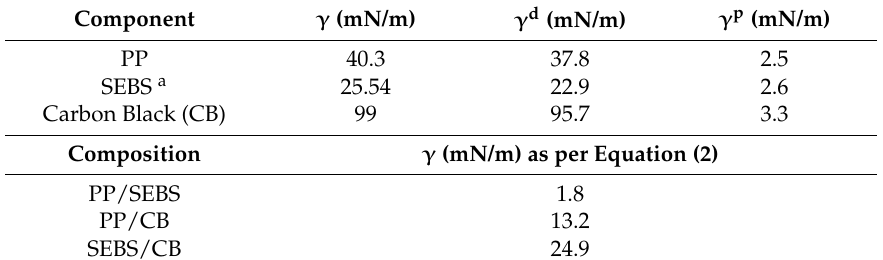
Table 3. Surface tension of PP and SEBS at room temperature [17,23,24] and the calculated interfacial tension values as per Equation